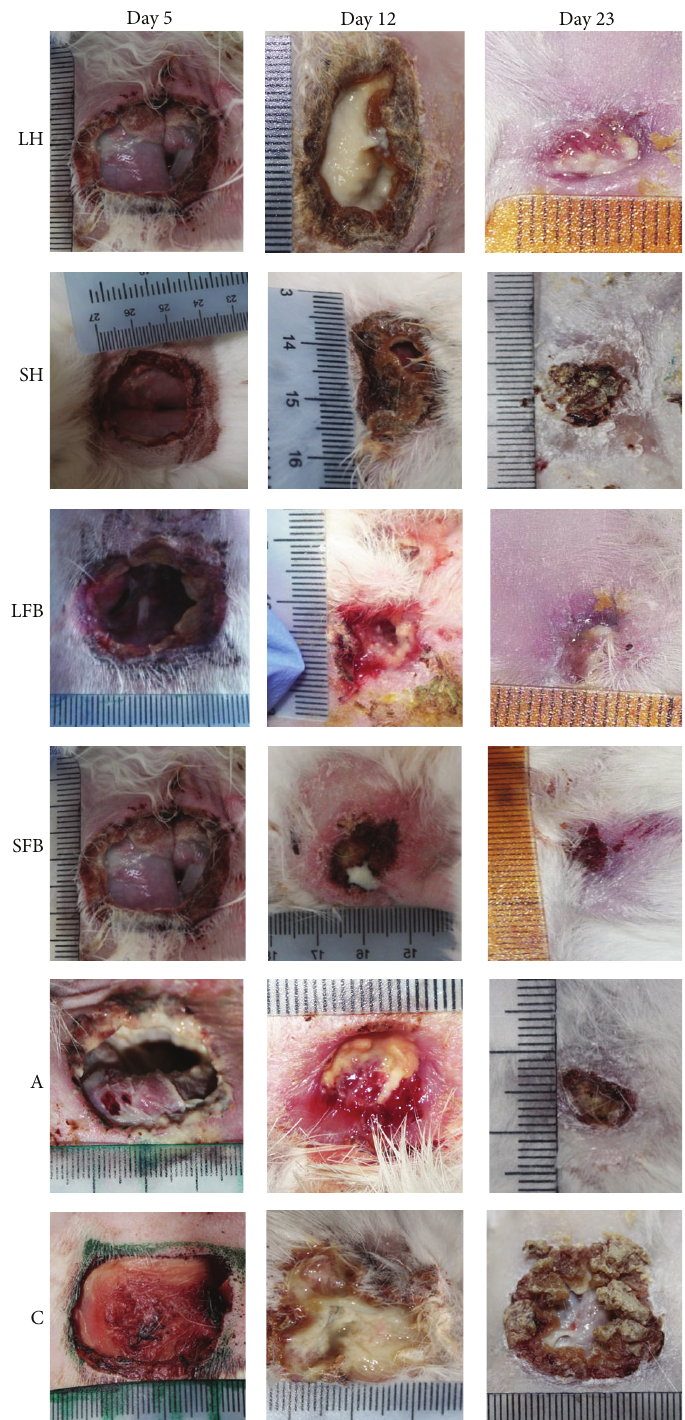
Figure 2: The evolution of diabetic rabbit wounds on days 5, 12, and 23, before and after applying treatment: LH: Lucilia sericata haemolymph- derived larval therapy, SH: Sarconesiopsis magellanica haemolymph-derived larval therapy, LFB: Lucilia sericata fat body-derived larval therapy, SFB: Sarconesiopsis magellanica fat body-derived larval therapy, A: antibiotic, and C: